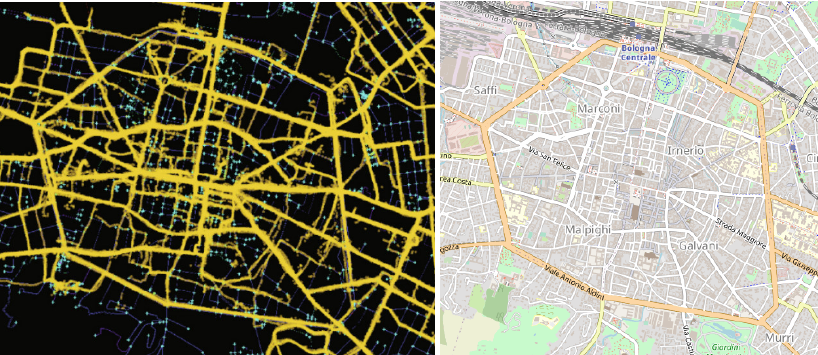
Figure 1. On the left, a graphical representation of the used GPS traces from Bella Mossa campaign (in yellow) overlapped with the SUMO network of the city of Bologna, Italy (in blue); on the right, the relative open street map of